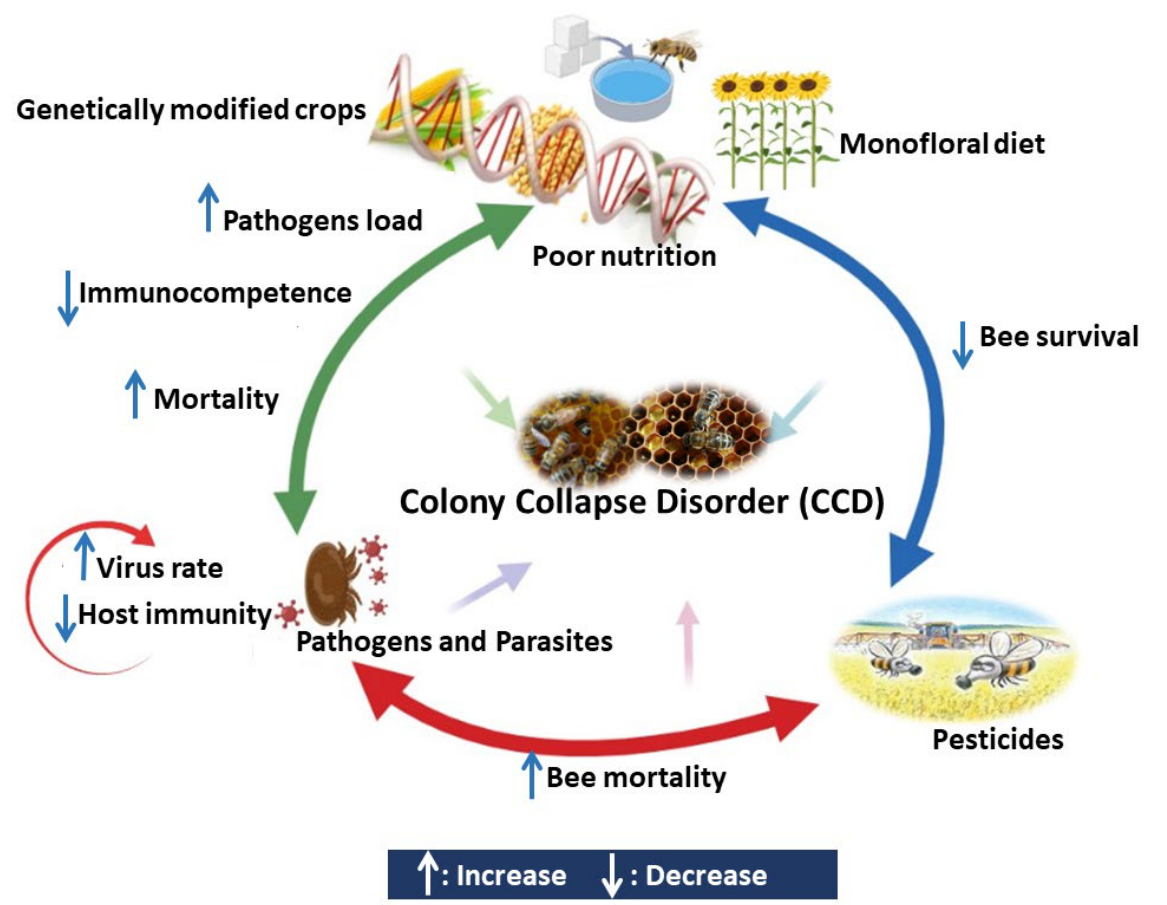
Figure 1. The impact on honeybees’ health when exposed to interaction between environmental and ecological stressors.